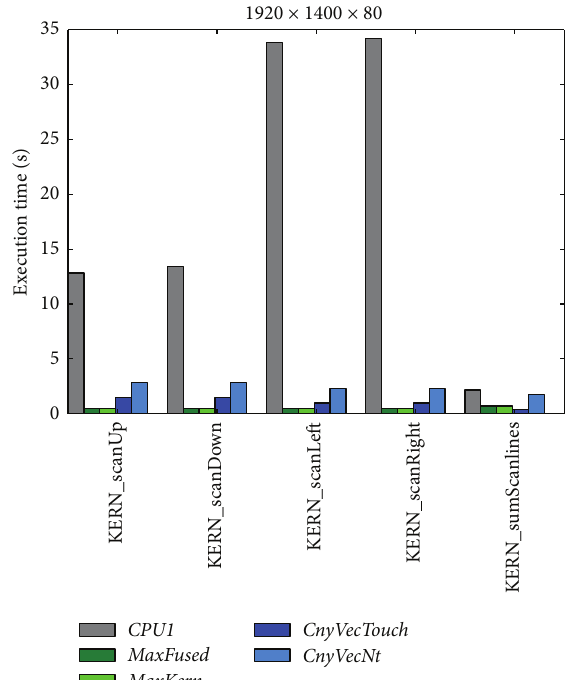
Figure 19: Execution times of individual scanline